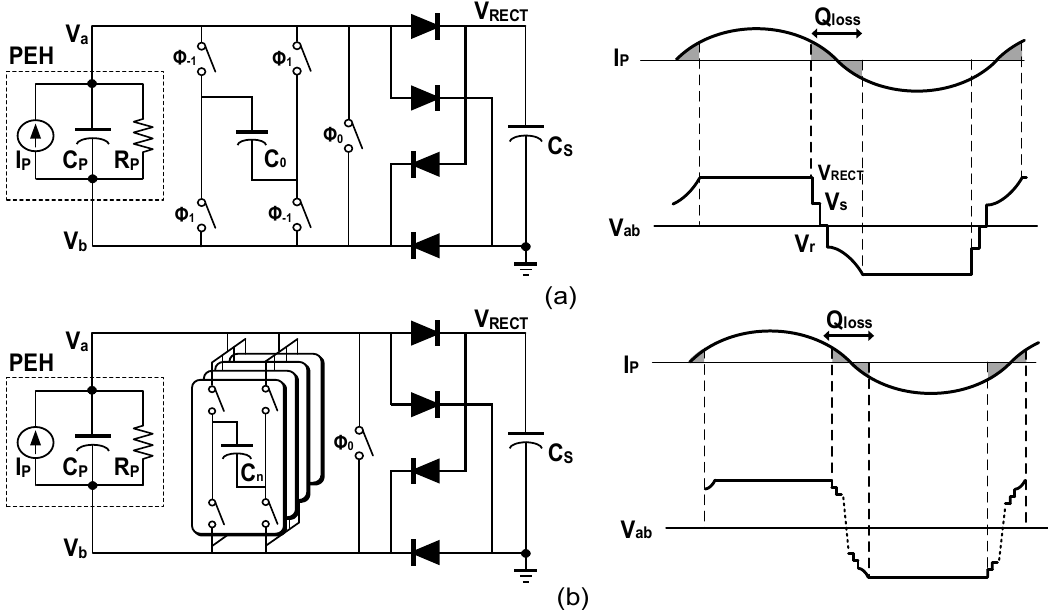
Figure 13. Interface circuit structures and I P , V P waveforms diagrams of ( a ) flipping with single capacitor, ( b ) flipping with capacitor array, respectively.